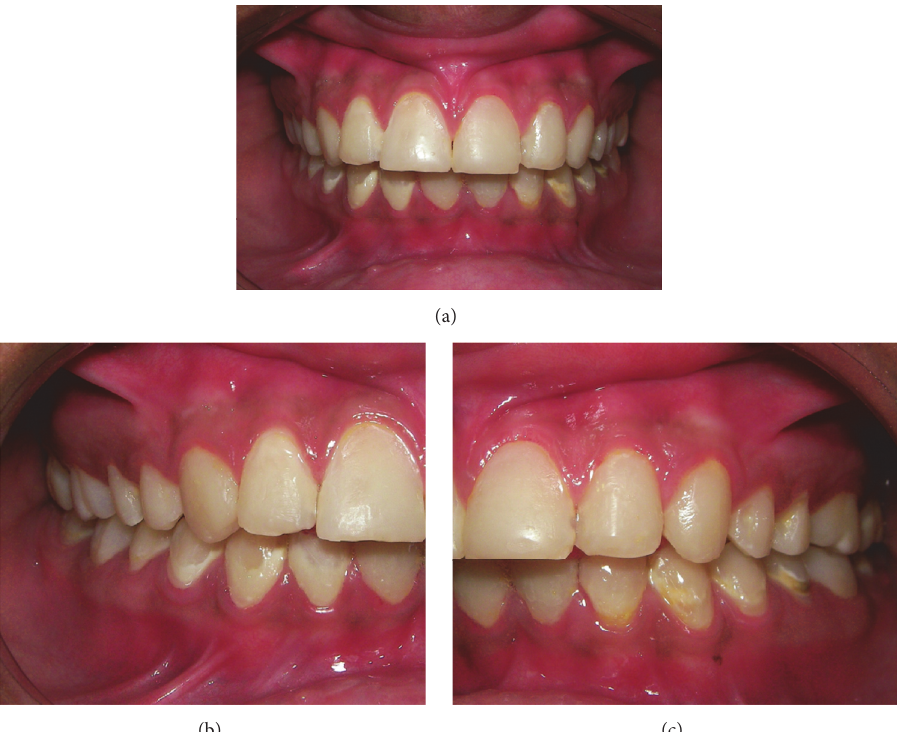
Figure 3: The clinical aspect after the restorative treatment (a). (b) and (c) are right and left sides, respectively.